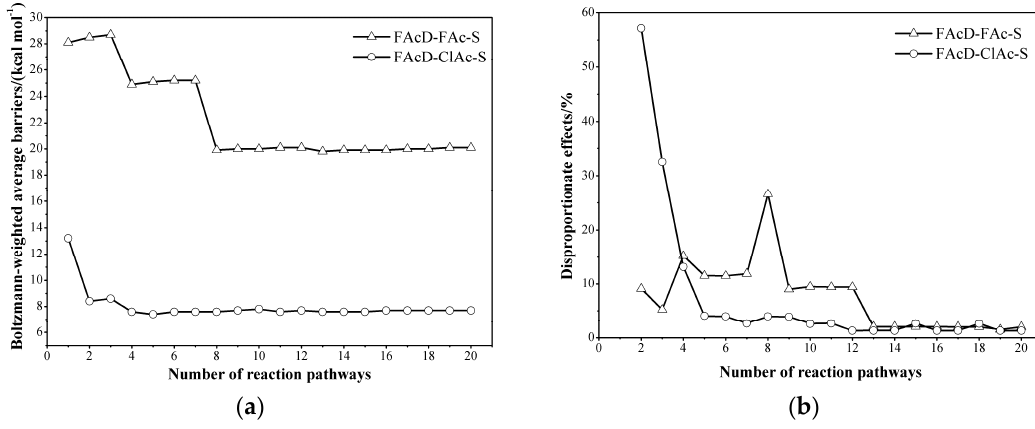
Figure 1. The convergence of ( a ) Boltzmann-weighted average barrier and ( b ) disproportionate effect of systems FAcD-FAc-S and FAcD-ClAc-S in 20 conformations.